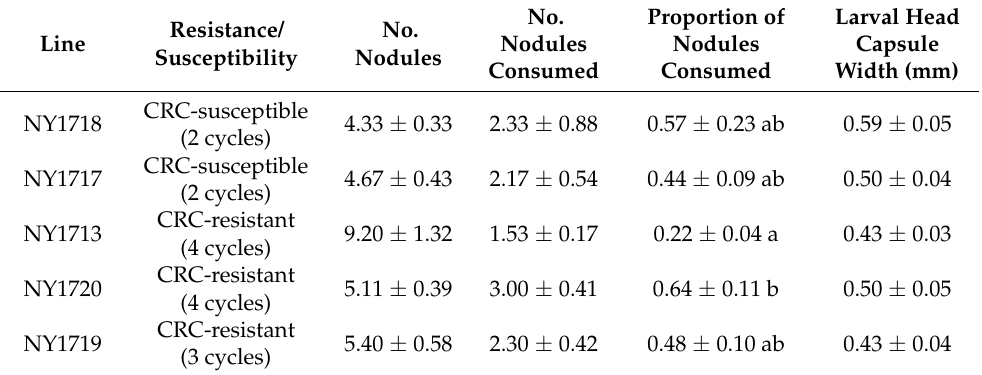
Table 1. Larval CRC feeding and development on each of five developmental alfalfa populations. Mean ( ± SEM) total number of nodules, number of nodules consumed by larval CRC, proportion of nodules consumed, and larval CRC head capsule width for each alfalfa populations. Different letters within column indicate significantly different means via Kruskall-Wallis rank sum test ( p ≤ 0.05).